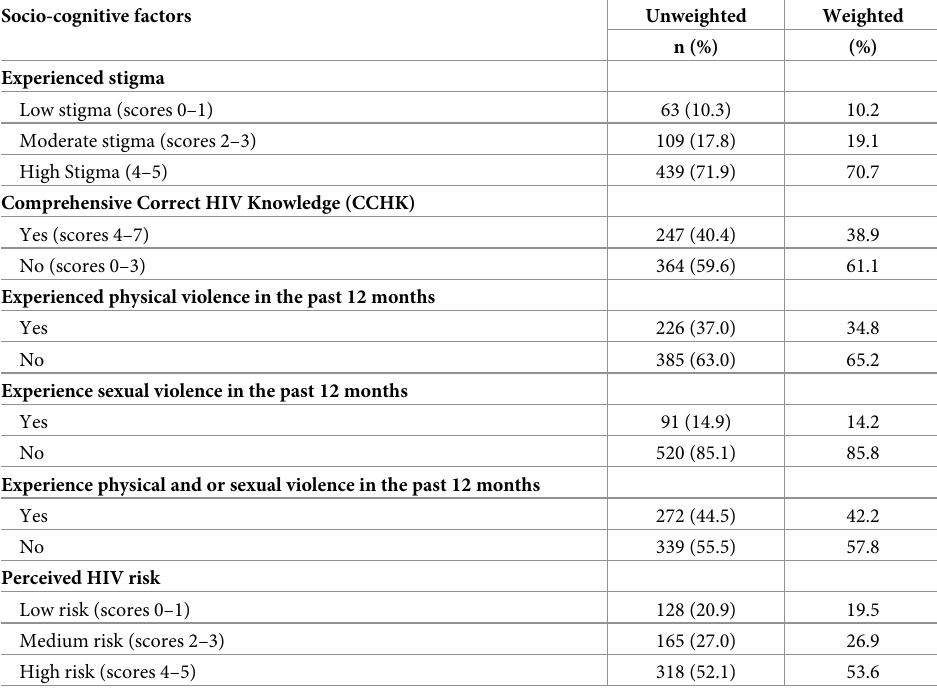
Table 3. Frequency distribution of socio-cognitive factors among people who inject drugs (n = 611). Socio-cognitive